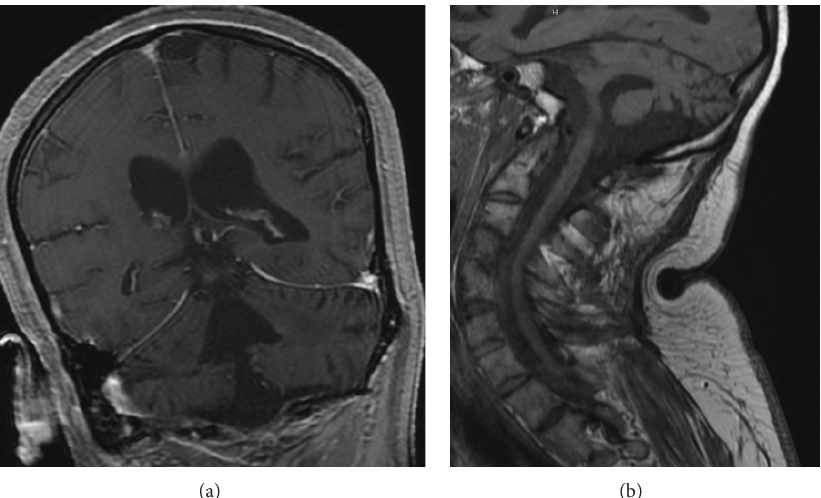
Figure 3: (a) and (b) (Seven months after initial MRI). MRI brain (a) showed marked atrophy of the brainstem, predominantly in the pons. MRI cervical spine (b) showed increased volume loss in the cervical cord on T-1 weighted